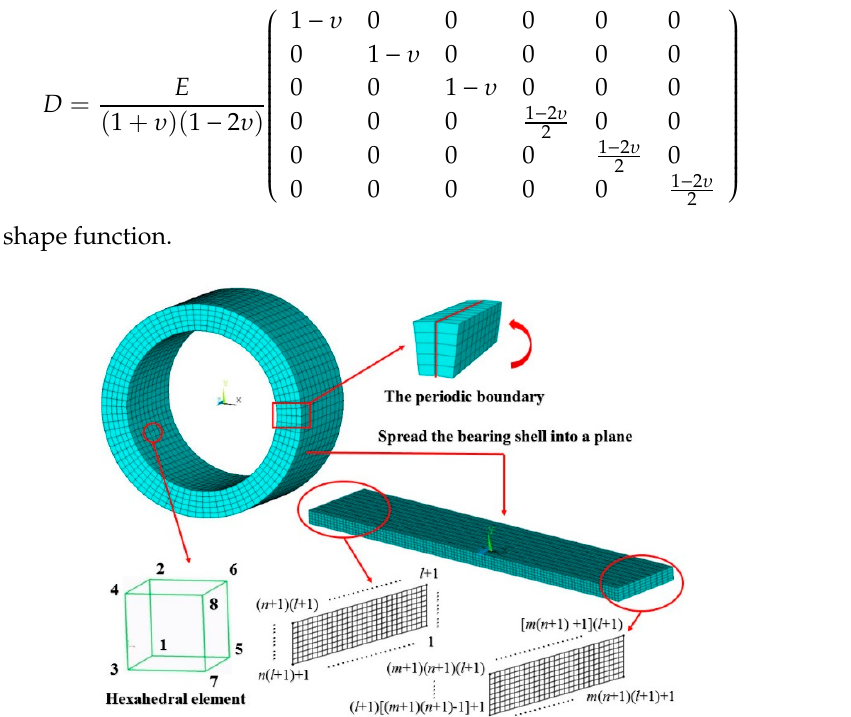
Figure 2. The entity unit and finite element model of gas microbearing.